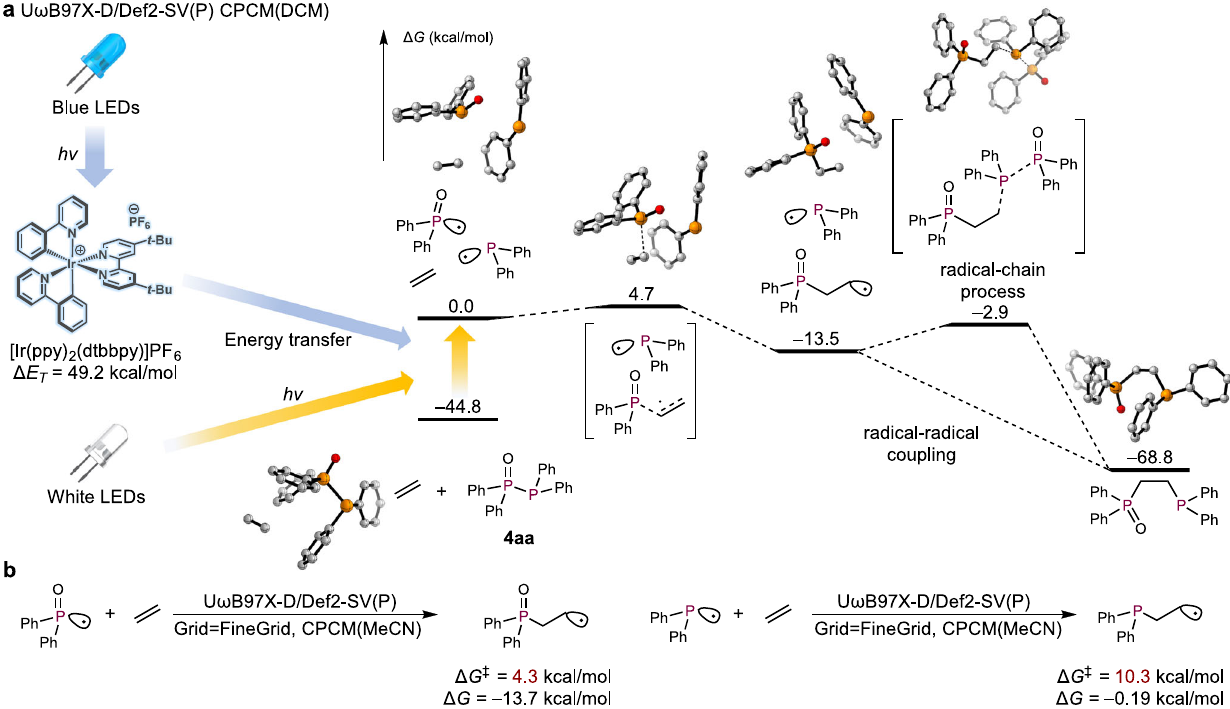
Fig. 6 | Mechanistic studies. a Plausible reaction mechanism. b Calculation results for the reaction of ethylene with phosphine-centered